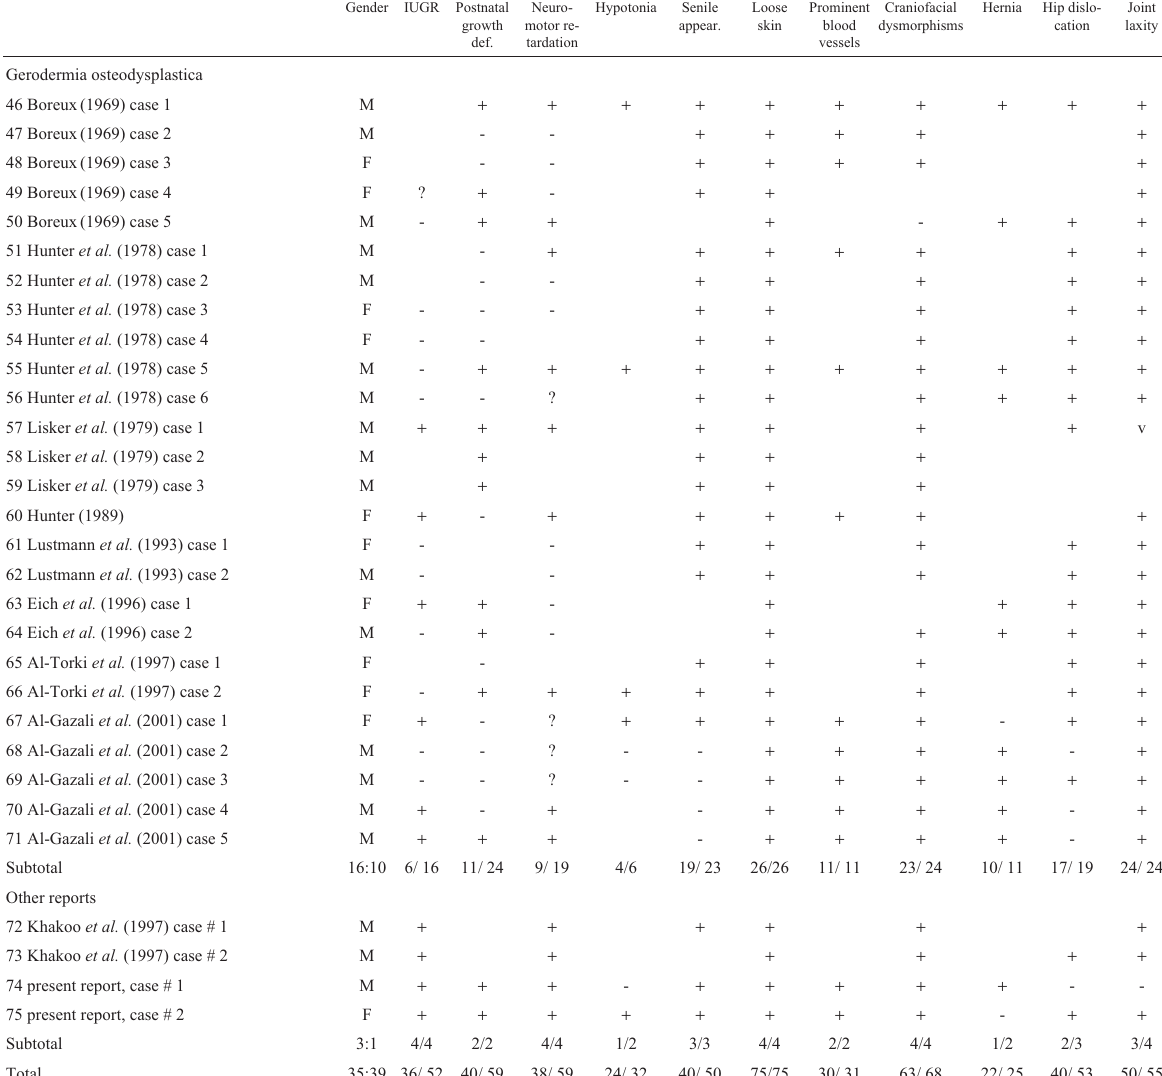
Gender IUGR Postnatal